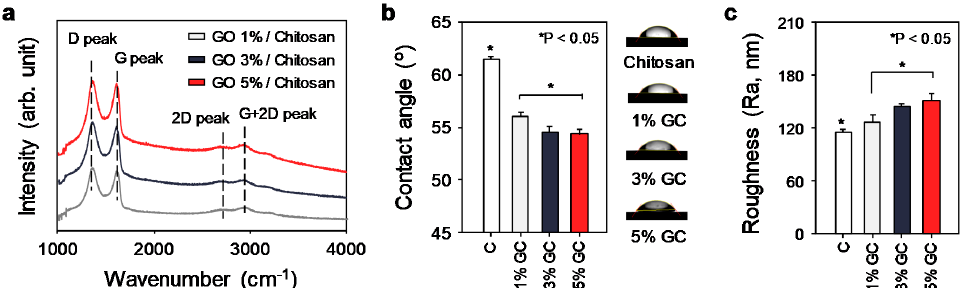
Figure 1. Characterization of the graphene–chitosan (GC) hybrid implants (1%, 3%, 5% GC) and chitosan (C) hybrid implant. ( a ) Raman spectra, ( b ) water contact angle, and ( c ) roughness measurement. The data were analyzed using one-way analysis of variance (ANOVA) (* p < 0.05).